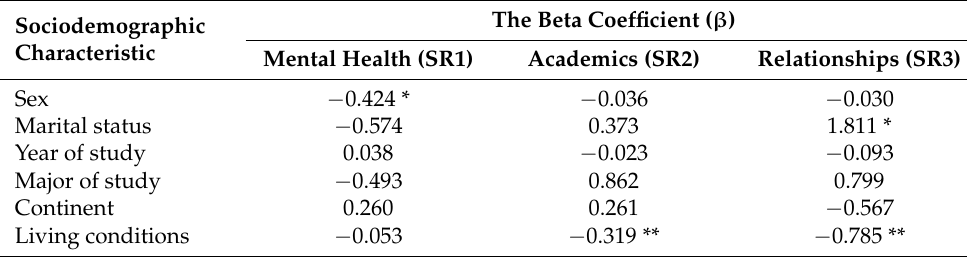
Table 7. Multivariate analyses on sociodemographic characteristics with academic resilience.